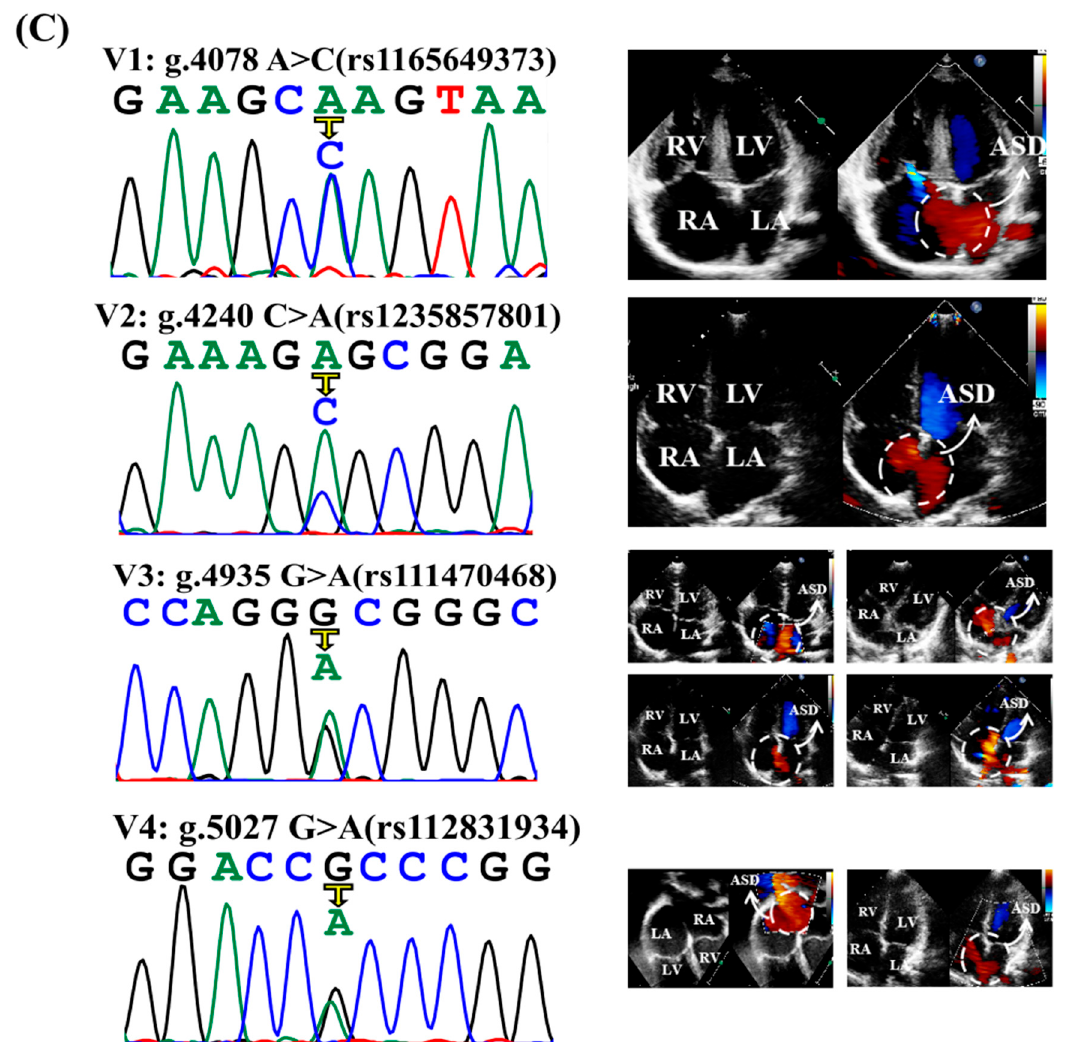
Figure 3. Dual-luciferase reporter gene assay process and echocardiography of ASD patients. ( A ) Procedure of cell function experiments. To confirm the effect of variants on promoter activity, wild-type and variant CITED2 gene promoter fragments were prepared, gene expression vectors were constructed, and HEK-293 cells and HL-1 cells were transfected. The transcriptional activity of wild-type and variant CITED2 gene promoters was detected by dual-luciferase reporter assay. DNA Pol, DNA polymerase. ( B ) Relative transcriptional activity of the CITED2 gene promoter in HEK293 (left panel) and HL-1 cells (right panel). The transcriptional activity of the wild-type CITED2 gene promoter was set as 100%, and the relative activity of the variant was calculated. Results are presented as the mean ± SD of three independent experiments, each in triplicate. pGL3-Basic: empty vector; WT: wild type; V1: pGL3-4078A>C, V2: pGL3-4240C>A, V3: pGL3-4935C>T, V4: pGL3-5027C>T. *, p < 0.05; **, p < 0.01; ***, p < 0.001. ( C ) Color Doppler echocardiography of parasternal short-axis view at aortic valve level. The imagine shows the four cardiac chambers (left Echo panels) and the left-to-right blood flow shunt from the left atrium to the right atrium through the ASD (dotted line circle and the arrow) shows ASD (arrow) in patients with variants of g.4078A>C, g.4240C>A, g.4935C>T, g.5027C>T. LV, left ventricle; LA, left atrium; RA, right atrium; RV, right ventricle; ASD, atrial septal defect.